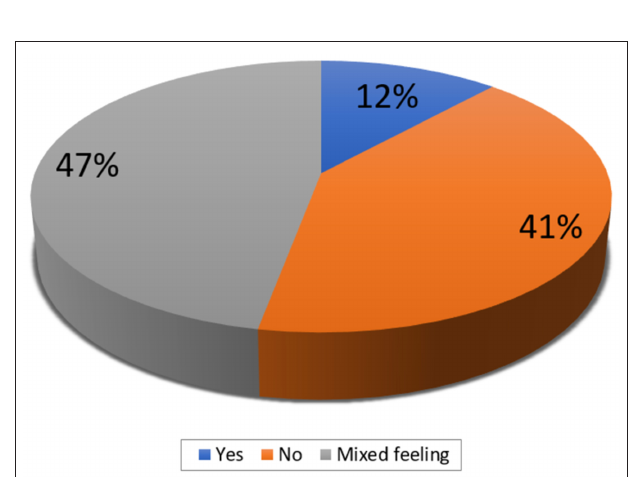
FIGURE 3 | The participants’ opinion on whether the actual form of the summary of findings table captures differences across overlapping systematic reviews (responses provided by 34